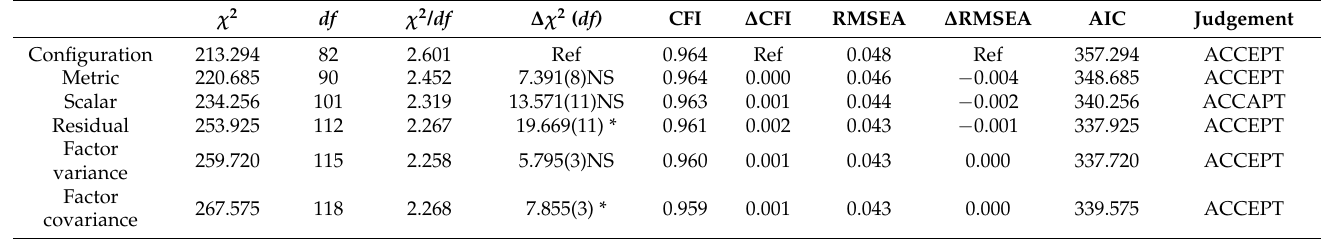
Table 6. Configuration, measurement, and structural invariances of the 3-factor model between age < 32 ( n = 344) and age ≥ 32 ( n = 353).